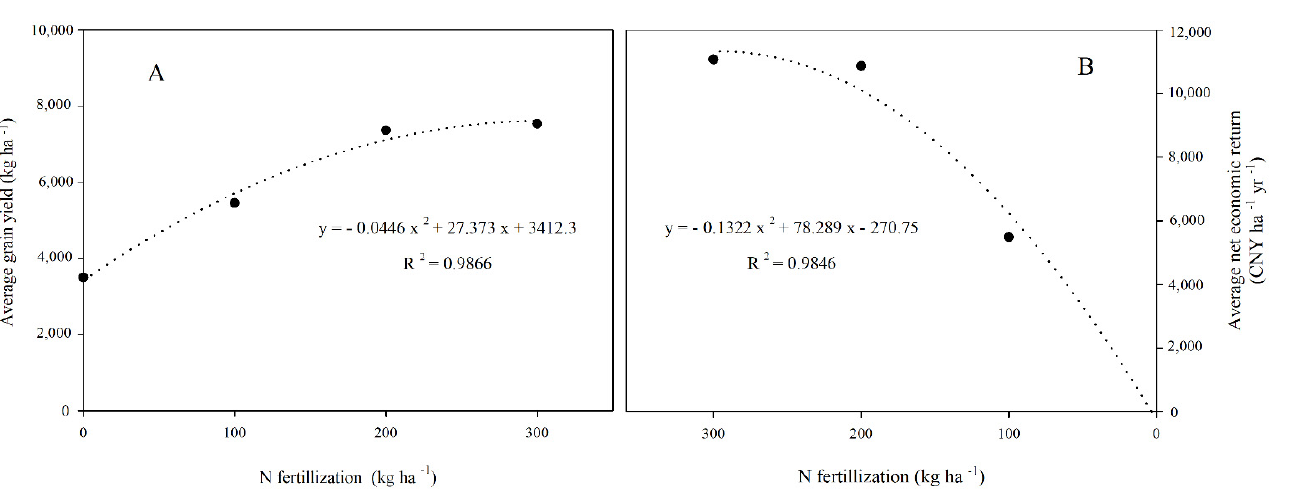
Table 4. Effects of four rates of nitrogen (N) application and growing seasons on evapotranspiration (ET), water use efficiency of grain yield (WUEg) and biomass yield (WUEb), and agronomic use efficiency of N fertilizer (AE) of maize.